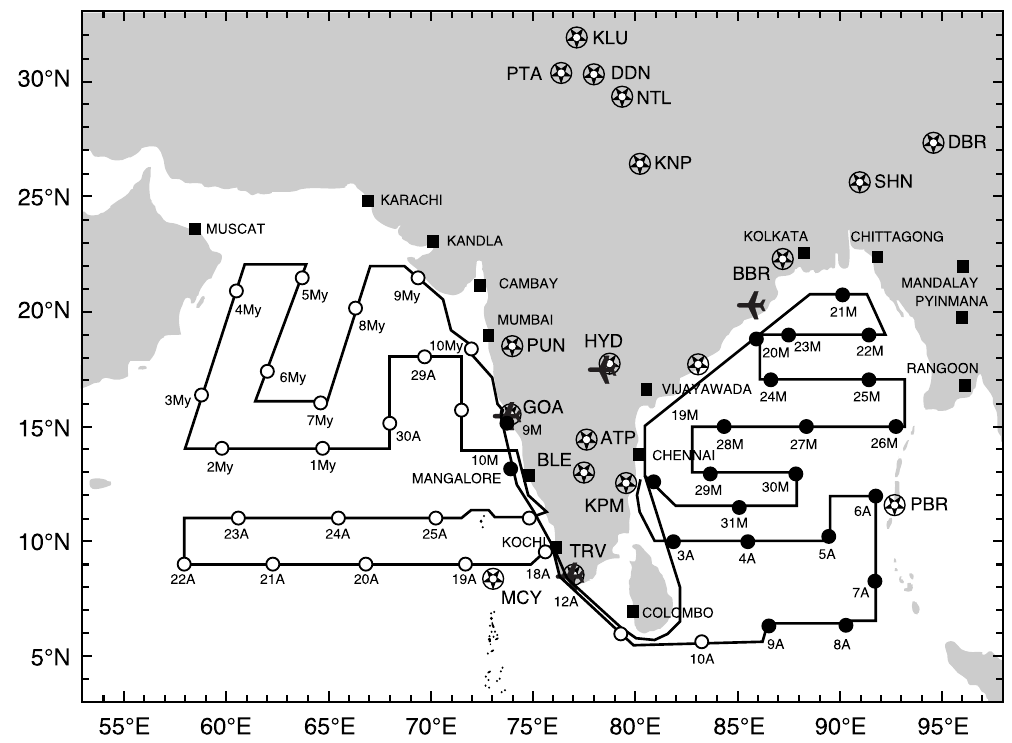
Fig. 14. Schematic representation of the operational phase of ICARB during March–May 2006. The continuous line across the ocean shows the SK223 cruise track. The points on the lines indicate the ship’s location at 05:30UTC for the date identified below it; the number stands for the day and the month is indicated by M for March, A for April, and My for May. The aircraft symbols show the bases from which the aircraft sorties were made. The other points represent the fixed stations on land where aerosol and gas measurements were made (redrawn from Moorthy et al., 2008, copyright 2008 by the Indian Academy of Sciences, reproduced with